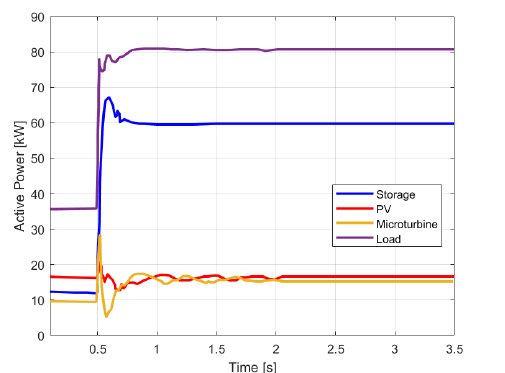
Figure 10. Simulation B: Active